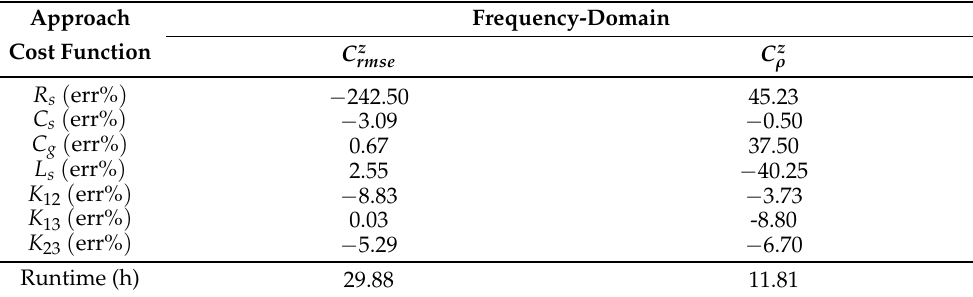
Table 3. Estimated Parameter Error Percentages obtained through the Frequency-Domain